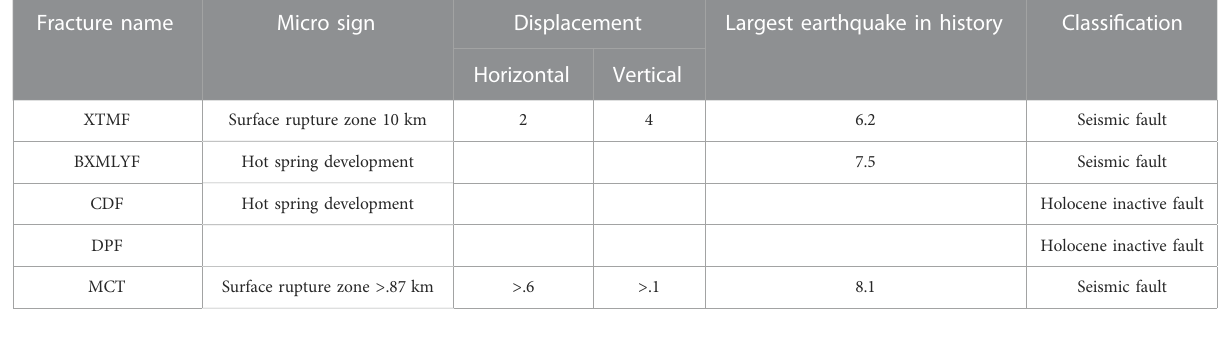
TABLE 1 Fracture properties in study area.